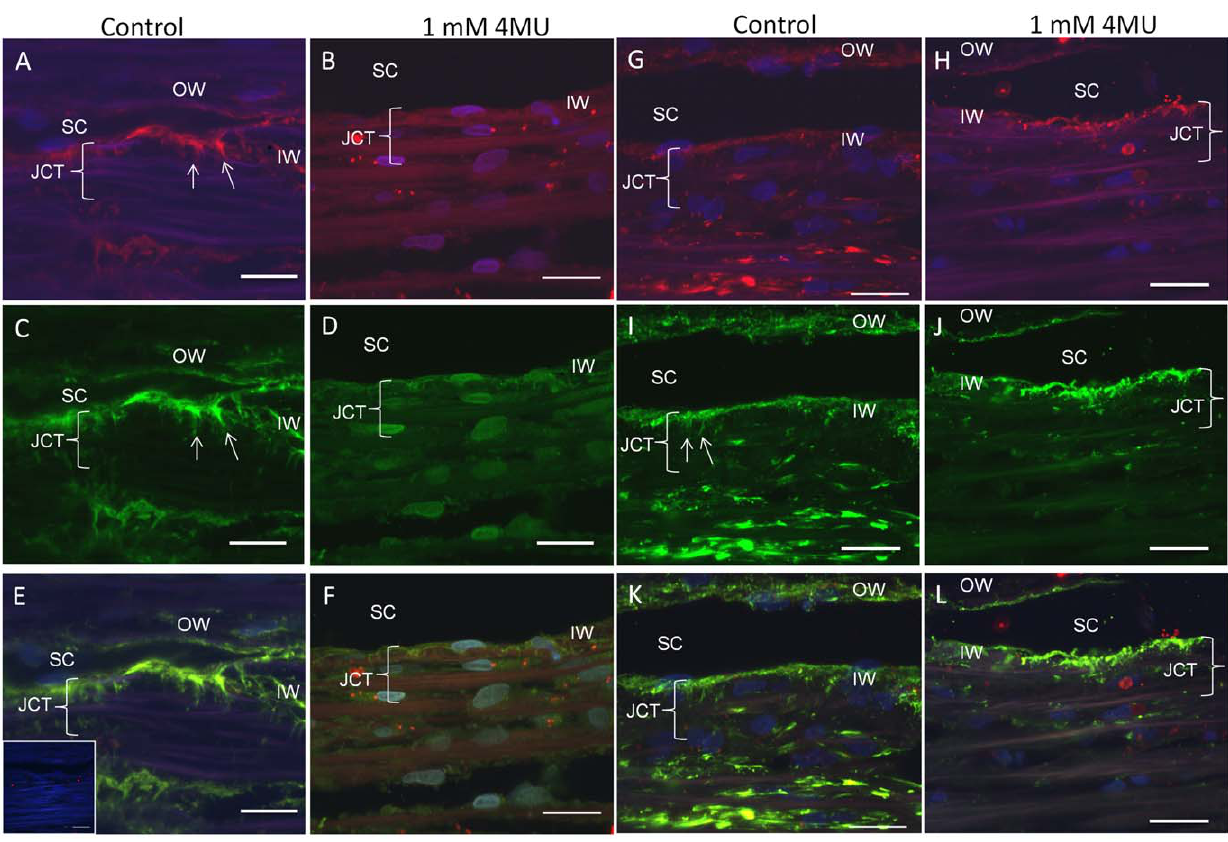
Figure 6. Immunostaining of 4MU-perfused trabecular meshwork tissue. Human anterior segments were perfused with vehicle (A, C, E, G, I, K) or 1 mM 4MU (B, D, F, H, J, L) continuously for 5 days. Frontal sections were cut and stained with bHAbp (A, B, G, H), versican (C, D) or fibronectin (I, J) antibodies. Colocalization of HAbp and versican (E, F) and HAbp and fibronectin (K, L) are also shown. Arrows point to pillar-like staining that runs perpendicular to Schlemm’s canal. Confocal acquisition settings were identical between control and 4MU-treated eyes. Inset in E shows negative control. SC=Schlemm’s canal; OW=outer wall; JCT=juxtacanalicular region; IW=inner wall. Scale bars=20 m m.